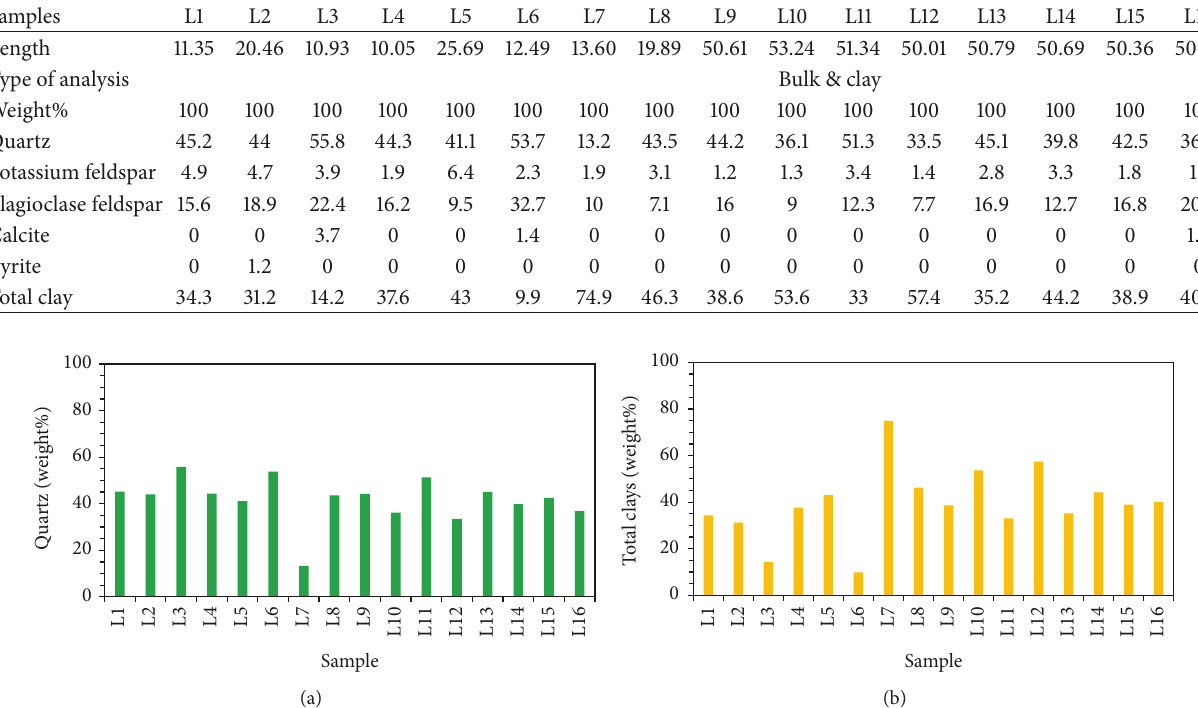
interval between two samples is about 12.5 m. As shown